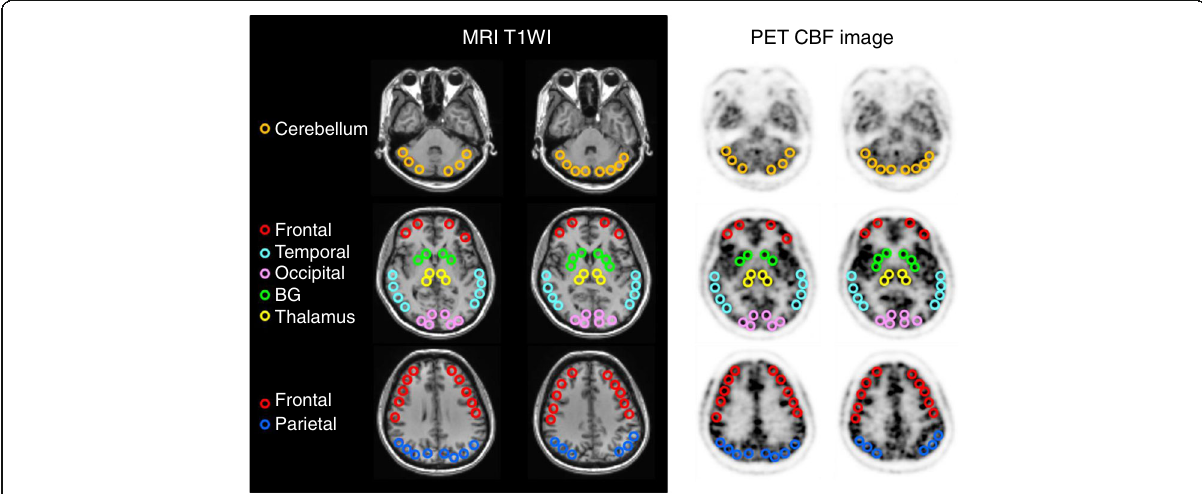
Fig. 1 ROIs on several representative slices of MRI (left two columns) and PET (right two columns). Different colors shows different locations of frontal (red), temporal (cyan), occipital (light pink), parietal (blue) lobes, basal ganglia (green), thalamus (yellow), and cerebellum (orange). ROIs were placed in the MRI images and transferred to the CBF-PET in the same